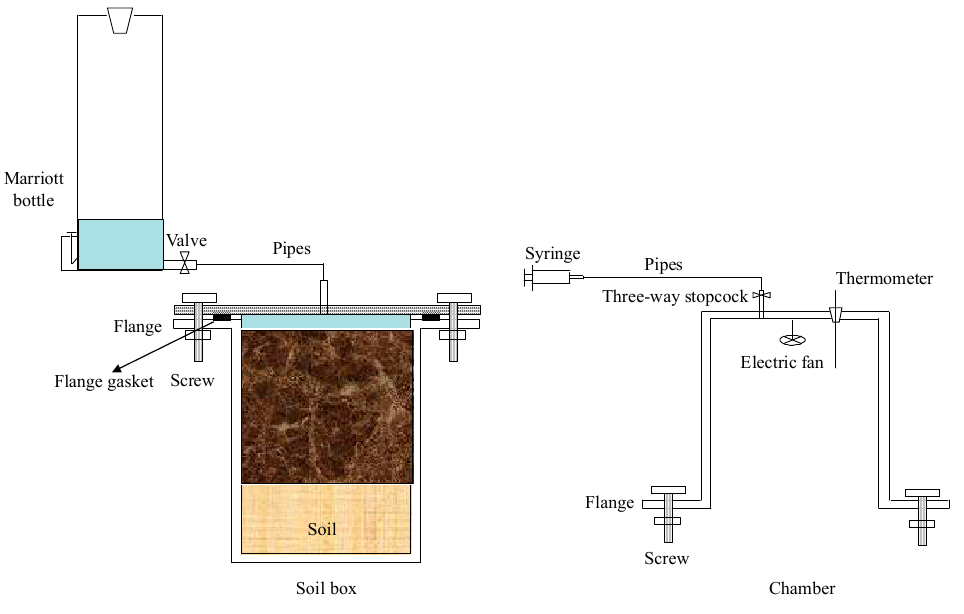
Figure 1. Sketch of soil box and the chamber.